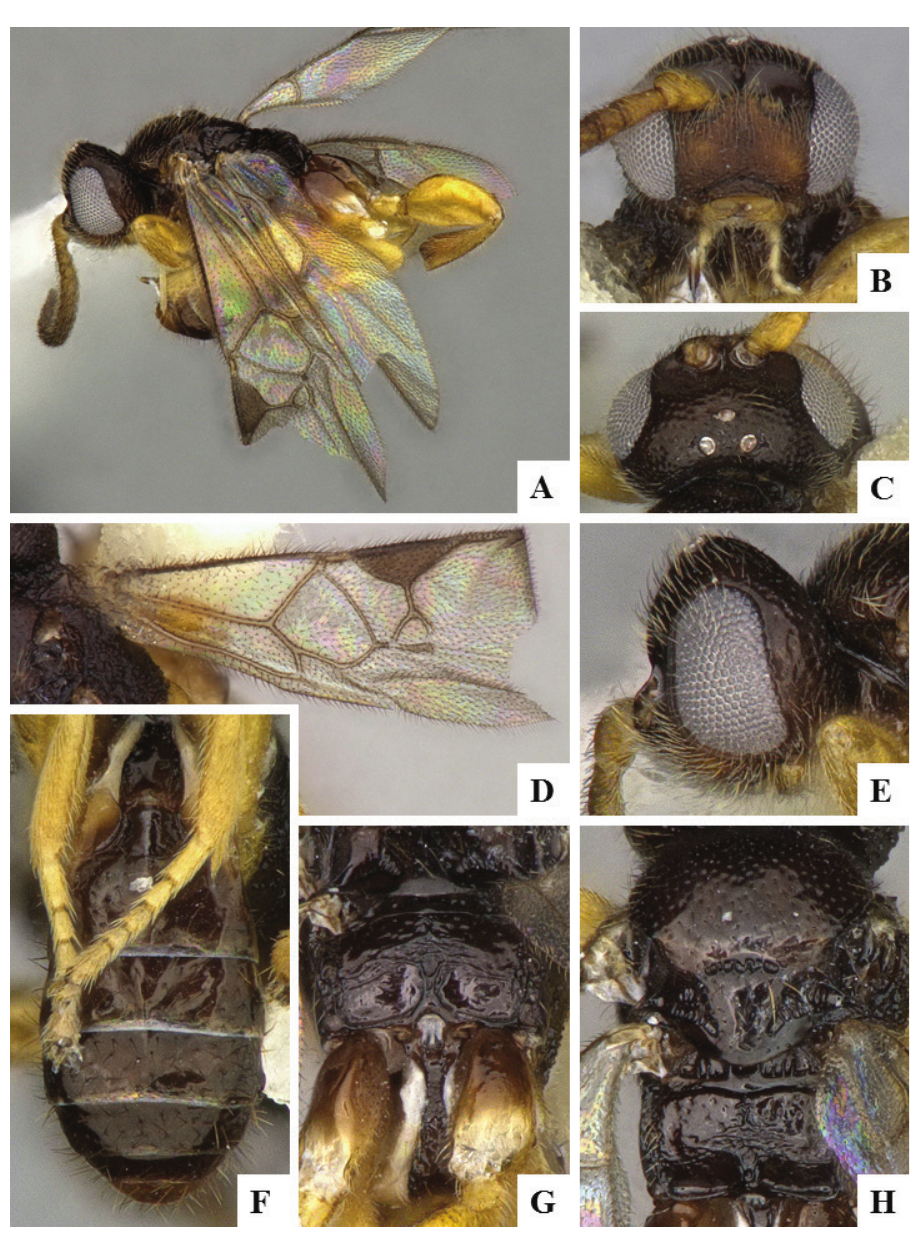
Figure 31. Markshawius thailandensis female holotype. A Habitus B Head frontal C Head dorsal D Fore wing E Head lateral F Metasoma dorsal G Propodeum H Mesosoma dorsal. Ovipositor sheaths almost without setae (with only very few, small setae near apex that are usually invisible at less than 100 × of magnification), ovipositor strongly narrow- ing toward apex, where it looks almost needle-like. Body measurements (mm). F2